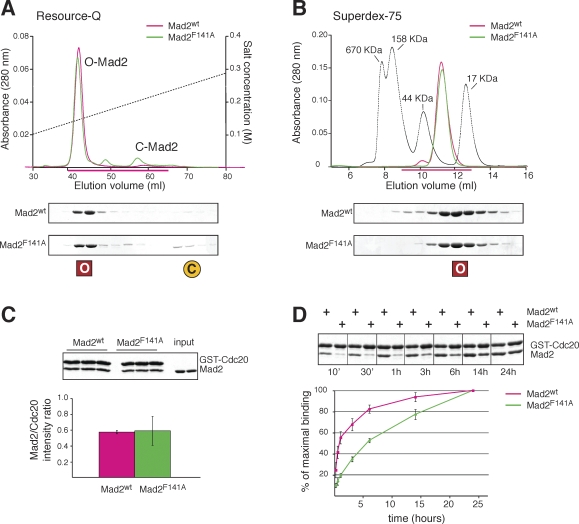
Mad2wt Binds Cdc20 Faster Than Mad2F141A
(A) Chromatographic analysis of Mad2wt and Mad2F141A. In agreement with previous studies [10,14], both Mad2 species can be purified in an O-Mad2 conformation that is identified based on the salt concentration (dotted line) at which these species elute from an anion exchange column. Mad2 species in the C-Mad2 conformation (yellow circle) elute at higher salt concentrations relative to the O-Mad2 species (red square) [10,14].(B) Mad2wt and Mad2F141A were separated on a Superdex-75 10/30 column. Both proteins elute as expected for monomeric forms. Dotted line represents the elution volumes of gel filtration standards.(C) GST-Cdc20111−138 (at 1 μM total concentration) was immobilized on GSH-agarose beads, and incubated for 24 h at room temperature with 1 μM Mad2wt or Mad2F141A. The binding reactions were then analysed by SDS-PAGE. Band intensities were quantified by densitometric analysis, and the ratio between GST-Cdc20 and Mad2 bands were used to calculate the fraction of Mad2/Cdc20 complexes. Standard deviations (error bars) were calculated from experiments repeated three or more times.(D) The experiment described in (C) was carried out as a time course using 1 μM GST-Cdc20111−138 and 2 μM Mad2wt or Mad2F141A. SDS-PAGE gels were digitized, and the intensity of the bound fractions plotted as a function of time. As in (B), error bars indicate the standard deviation calculated from three or more experiments.